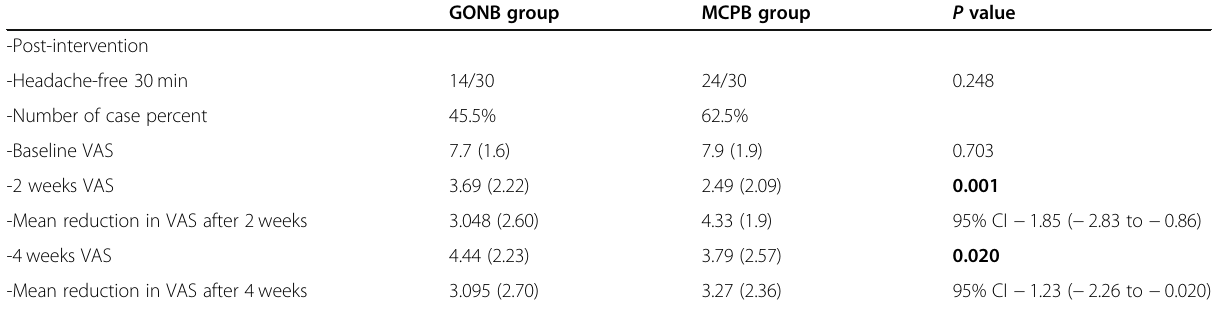
Table 2 Headache intensity presented as VAS (primary outcome)